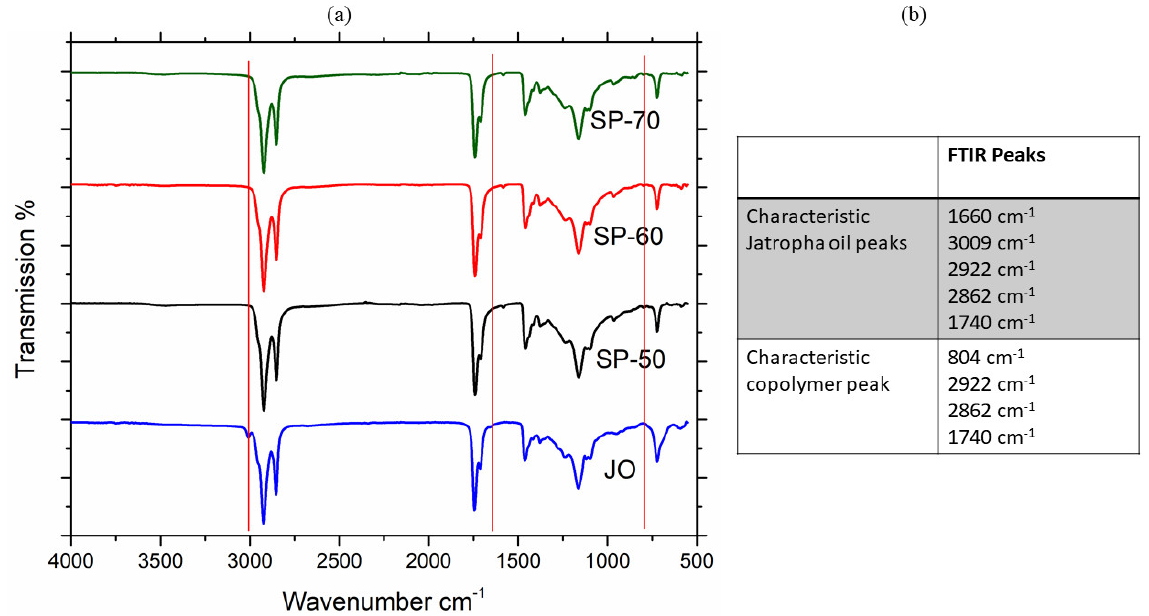
Figure 1. ( a )FTIR-ATR spectra of S polymers with different S loading and Jatropha oil and ( b ) shows the characteristic the characteristic peaks.